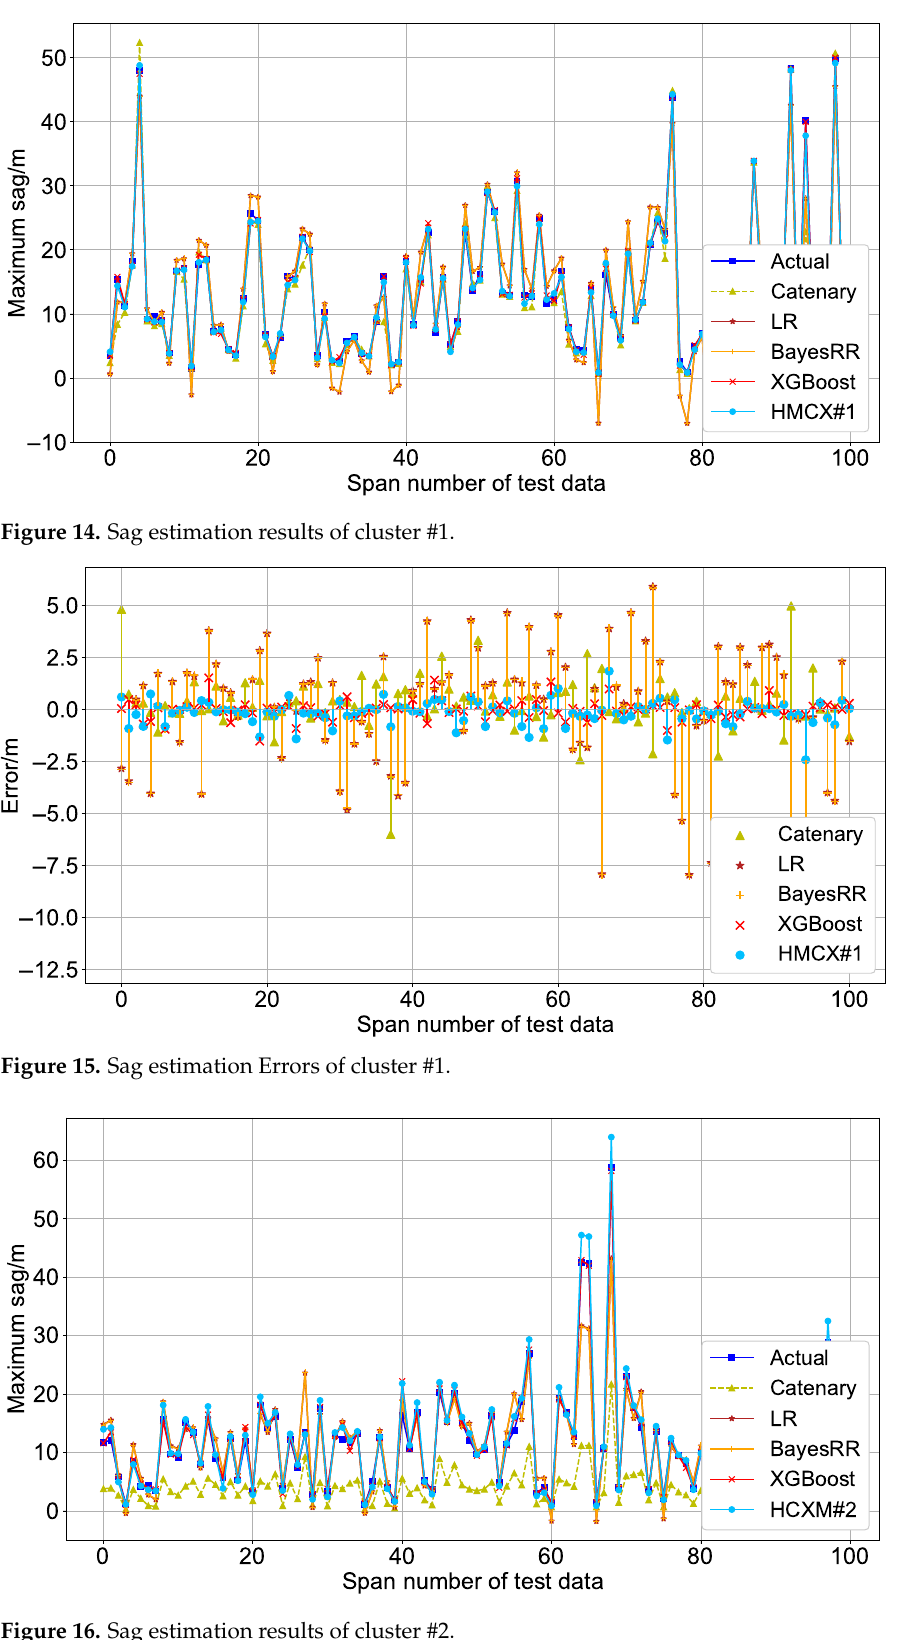
Figure 16. Sag estimation results of cluster